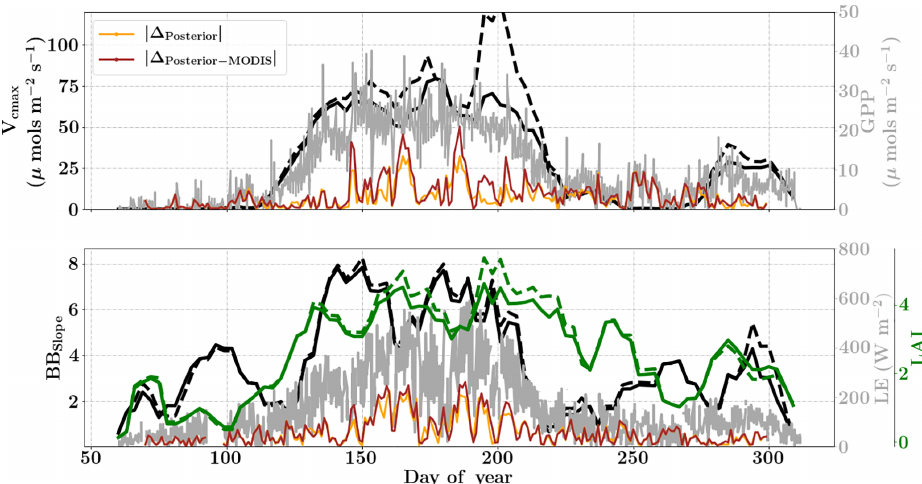
Figure 12. Figure showing the seasonal variability in retrieved parameter values of V cmax , BB slope and LAI for the Missouri Ozark site using a 3-day moving window inversion approach for the year 2007. The actual points in the time series (grey lines) of the GPP and LE fluxes used as the target observations ( Y ) for the moving window inversion approach are shown in the background. The figure shows the comparison of the retrieved parameters using only GPP and LE fluxes (shown as dashed lines) as well as using a combination of fluxes and MODIS reflectance (shown as solid lines). The results show reasonable trends in the retrieved parameters along with their sensitivity to GPP and LE fluxes across the growing